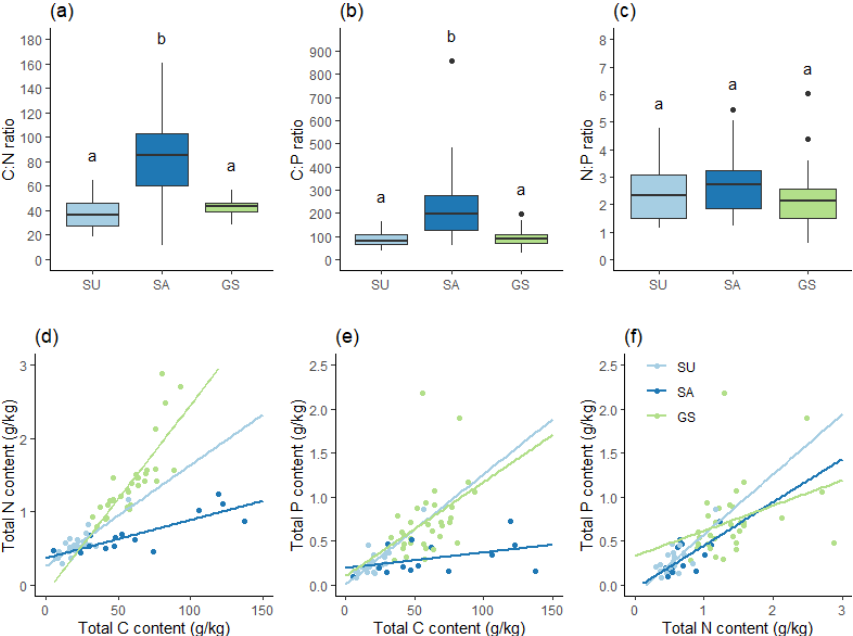
Figure 6. Stoichiometry: (a) C : N ratio, (b) C : P ratio, (c) N : P ratio, correlations of (d) C and N, (e) C and P, and (f) N and P; these are for SU ( n = 22), SA ( n = 14) and green space (GS; n = 32) soils. Different letters indicate a statistically significant difference between soil categories at the 0.05